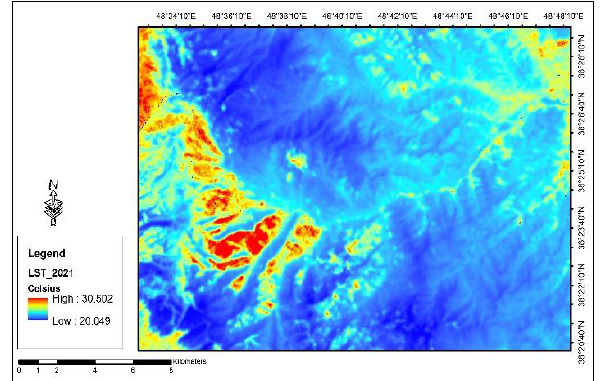
Figure 5. Land surface temperature in degrees